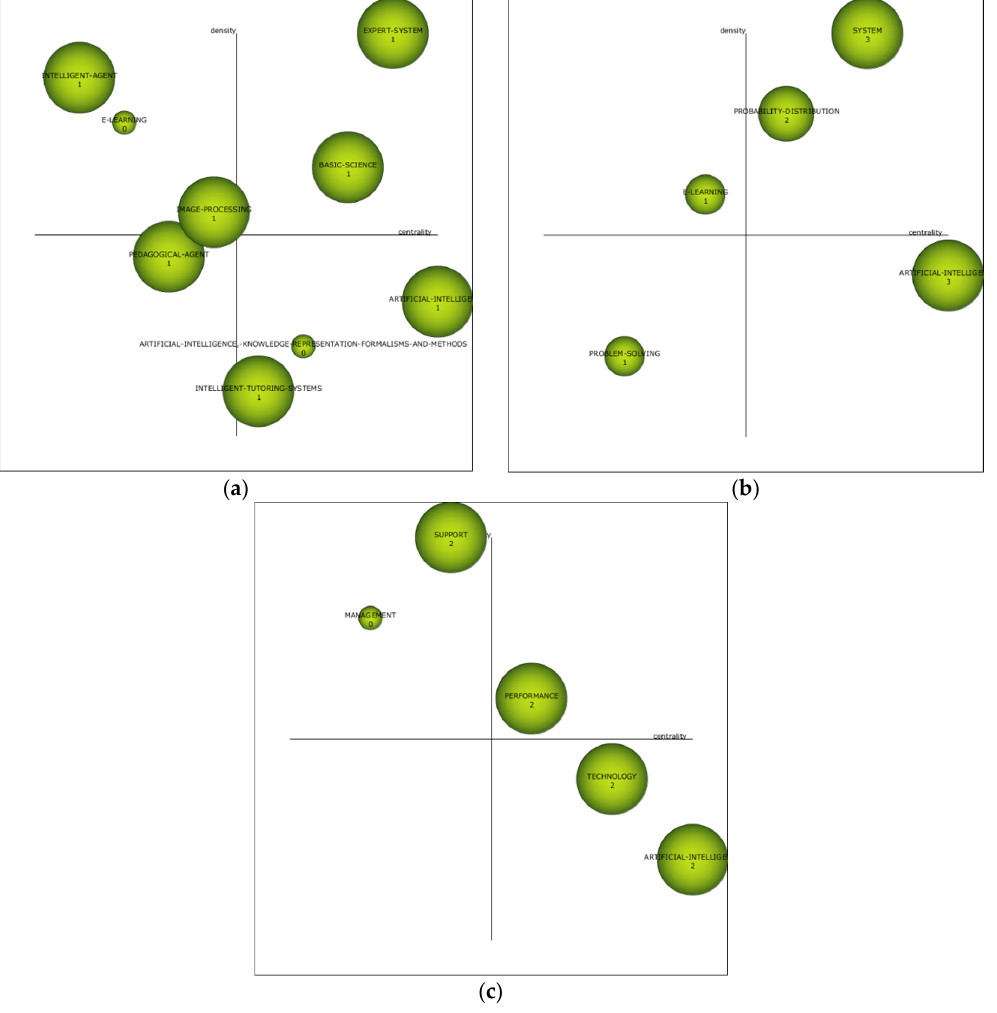
Figure 4. Strategic diagram by AI index-h. Note: ( a ) Range 1956–2006; ( b ) Range 2007–2016; ( c ) Range 2017–2019.